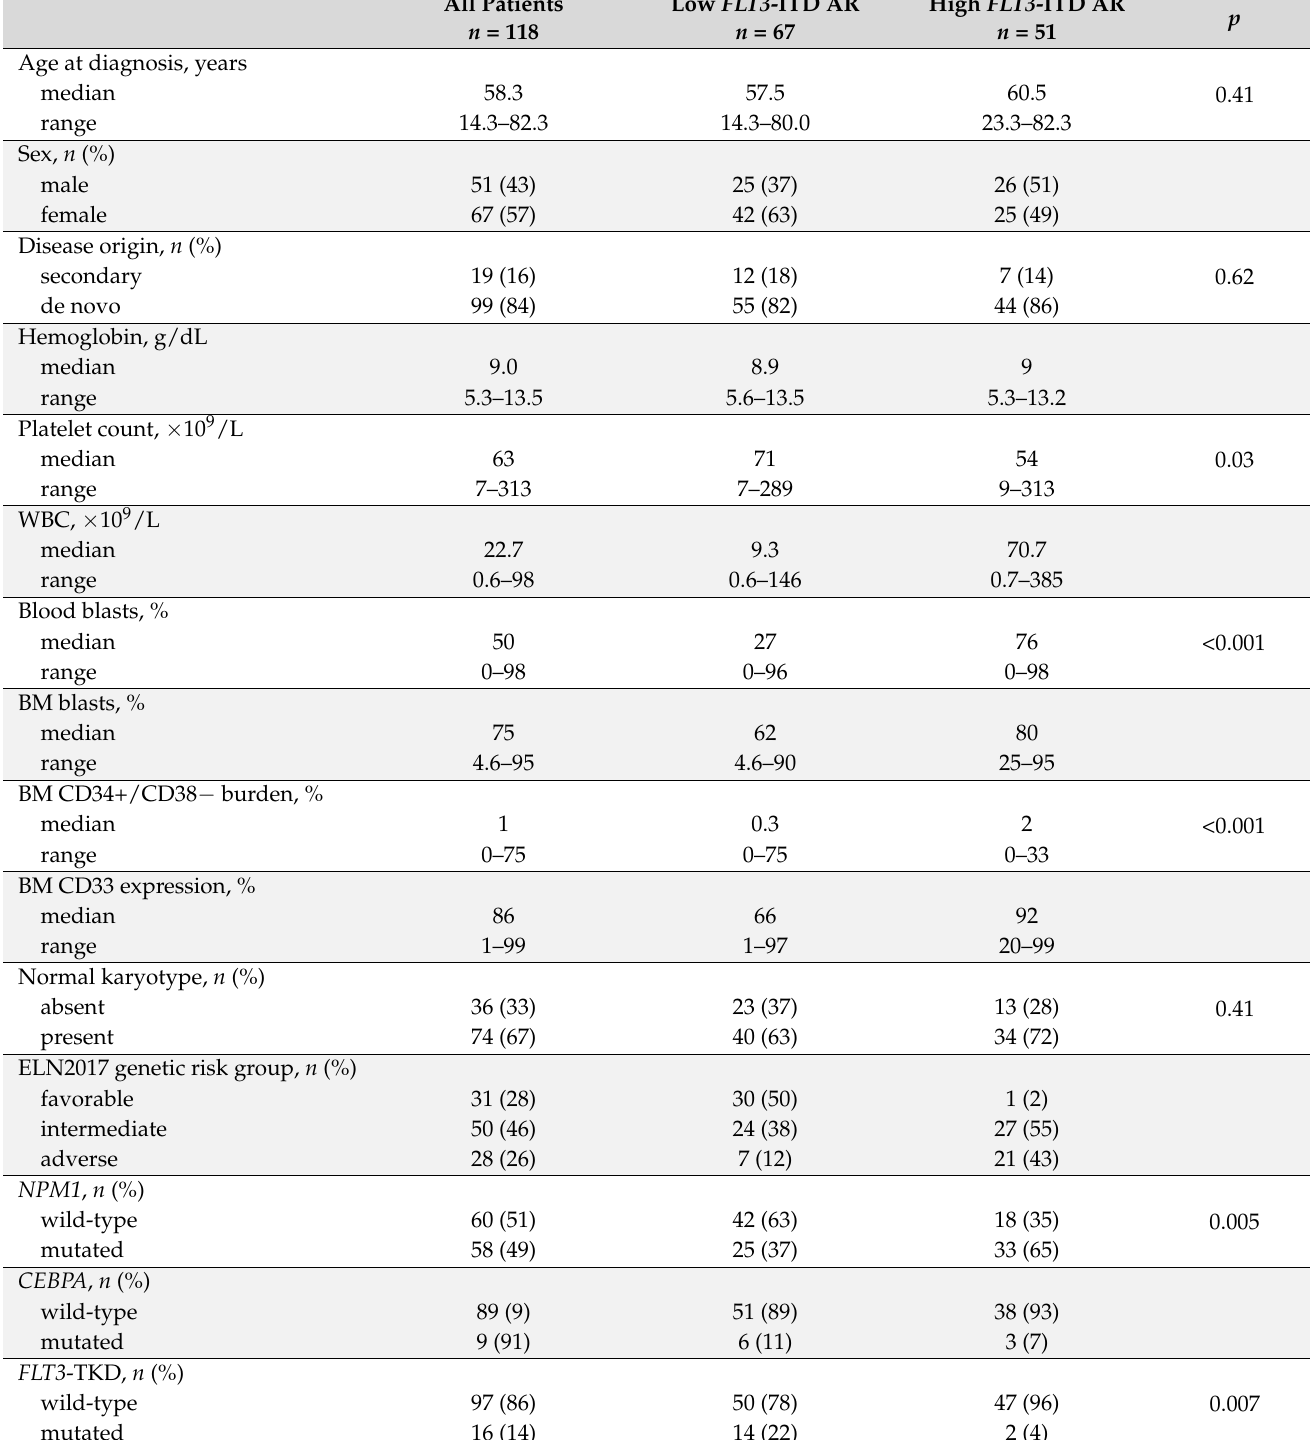
Table 1. Clinical and genetic characteristics for all patients according to FLT3 -ITD allelic ratio at diagnosis (high vs. low, 0.5 cuts), n =